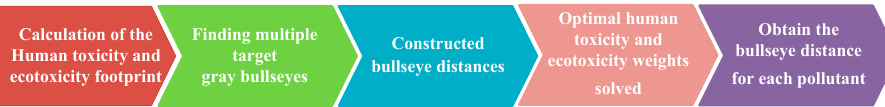
Figure 5. Integrated human toxicity and ecotoxicity evaluation steps.